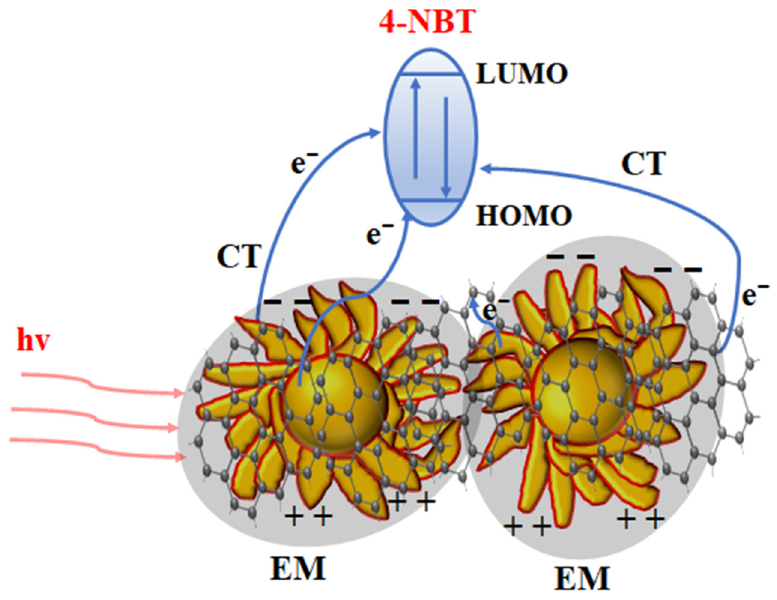
Figure 9. Schematic of Raman enhancement mechanism of GP-GERTs.